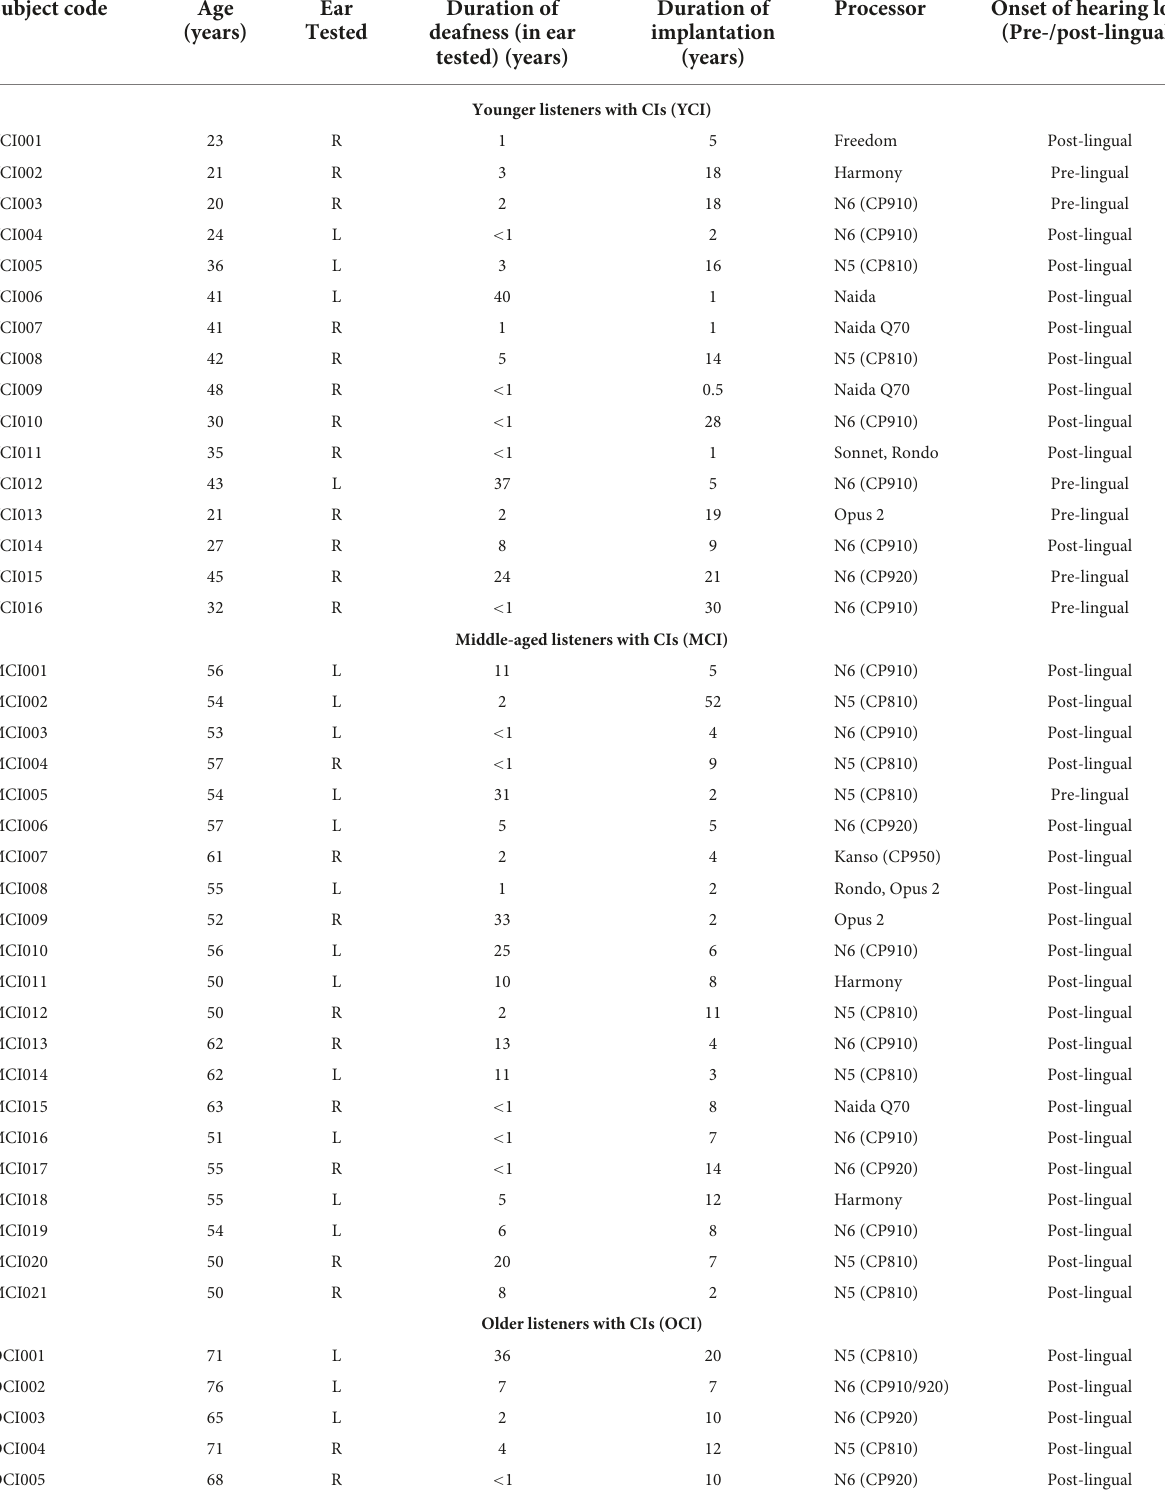
TABLE 1 Demographic information for listeners with